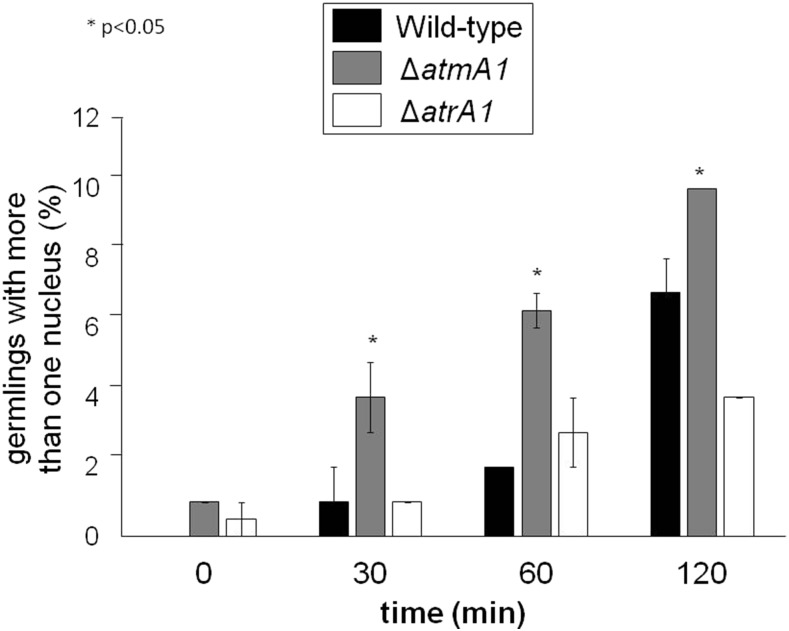
The ΔatmA mutant has a defective DNA replication checkpoint. Conidia were grown for 5 hr at 37° in complete medium (YG) + 100 mM HU then washed and incubated again in YG medium for different periods of time. The number of nuclei in each conidium was assessed by Hoescht staining (50 germlings were counted per each repetition, average of three independent experiments ± SD).